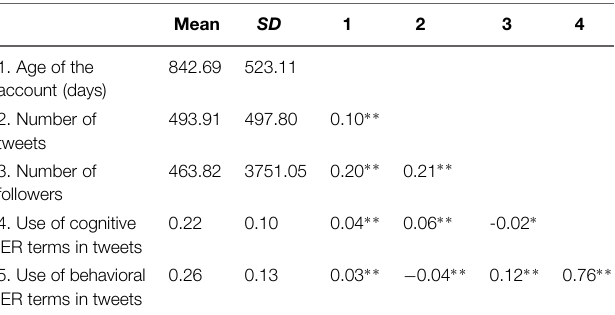
TABLE 3 | Correlations between main study variables in Study 2.